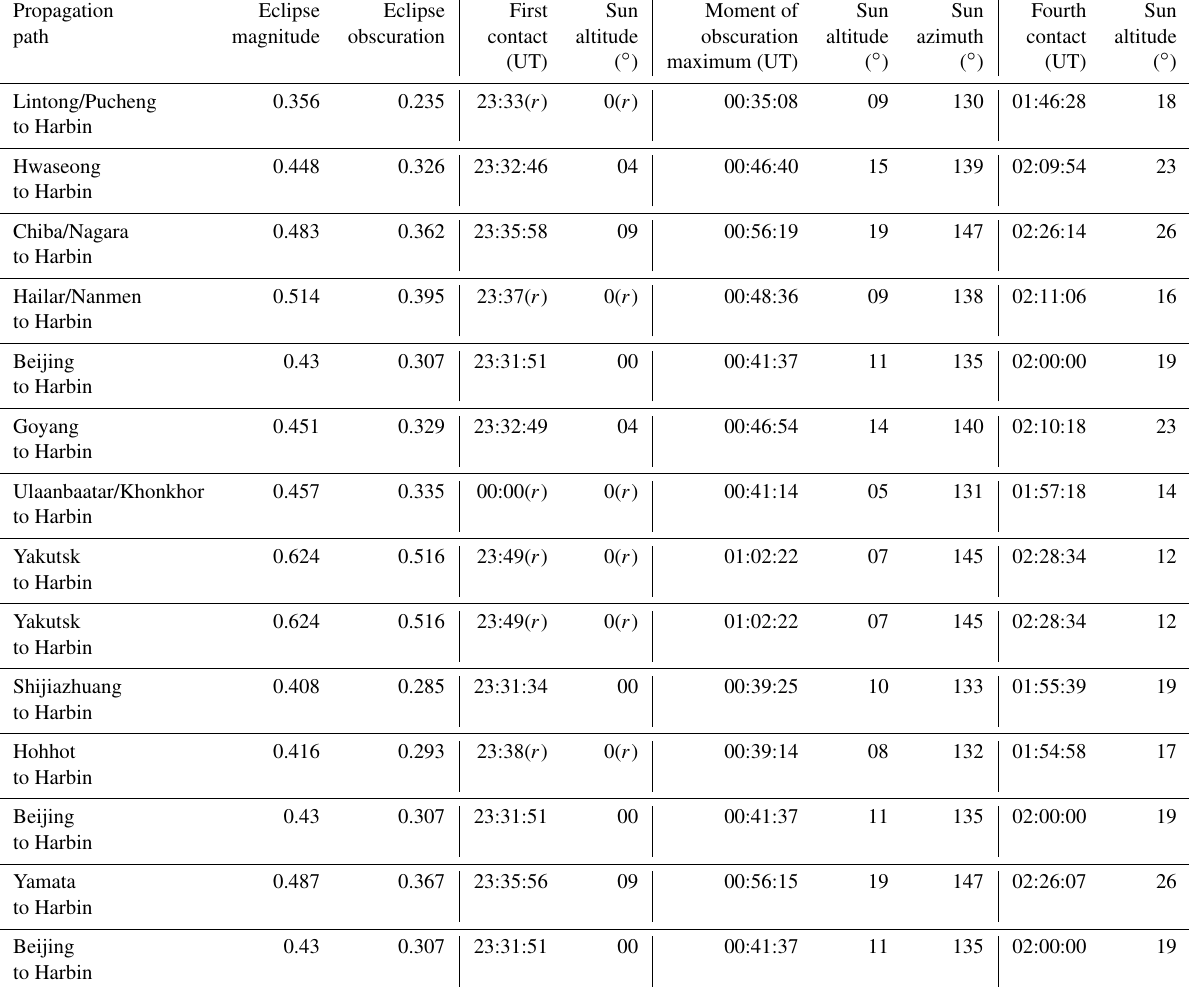
Table 3. Basic information on the solar eclipse parameters at 100km altitude over the propagation path midpoints. Retrieved from https: //eclipse.gsfc.nasa.gov/JSEX/JSEX-AS.html, last access: 20 September